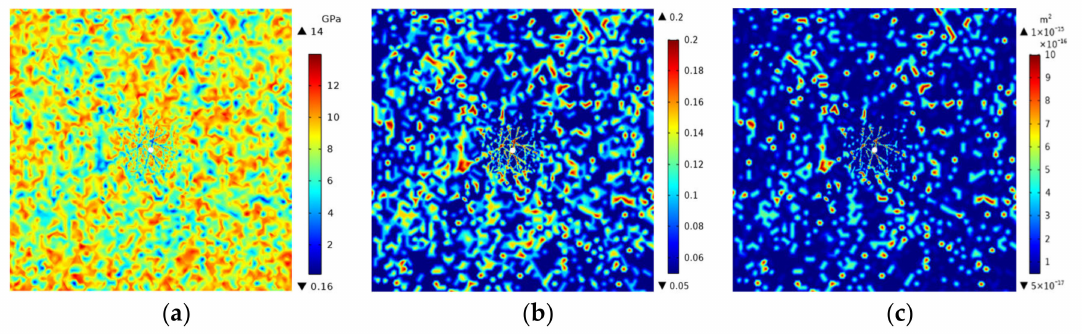
Figure 3. Images of parameters generated by im ( x , y ). ( a ) Elastic modulus E 2 ; ( b ) initial porosity φ 0 ; ( c ) initial permeability k 0